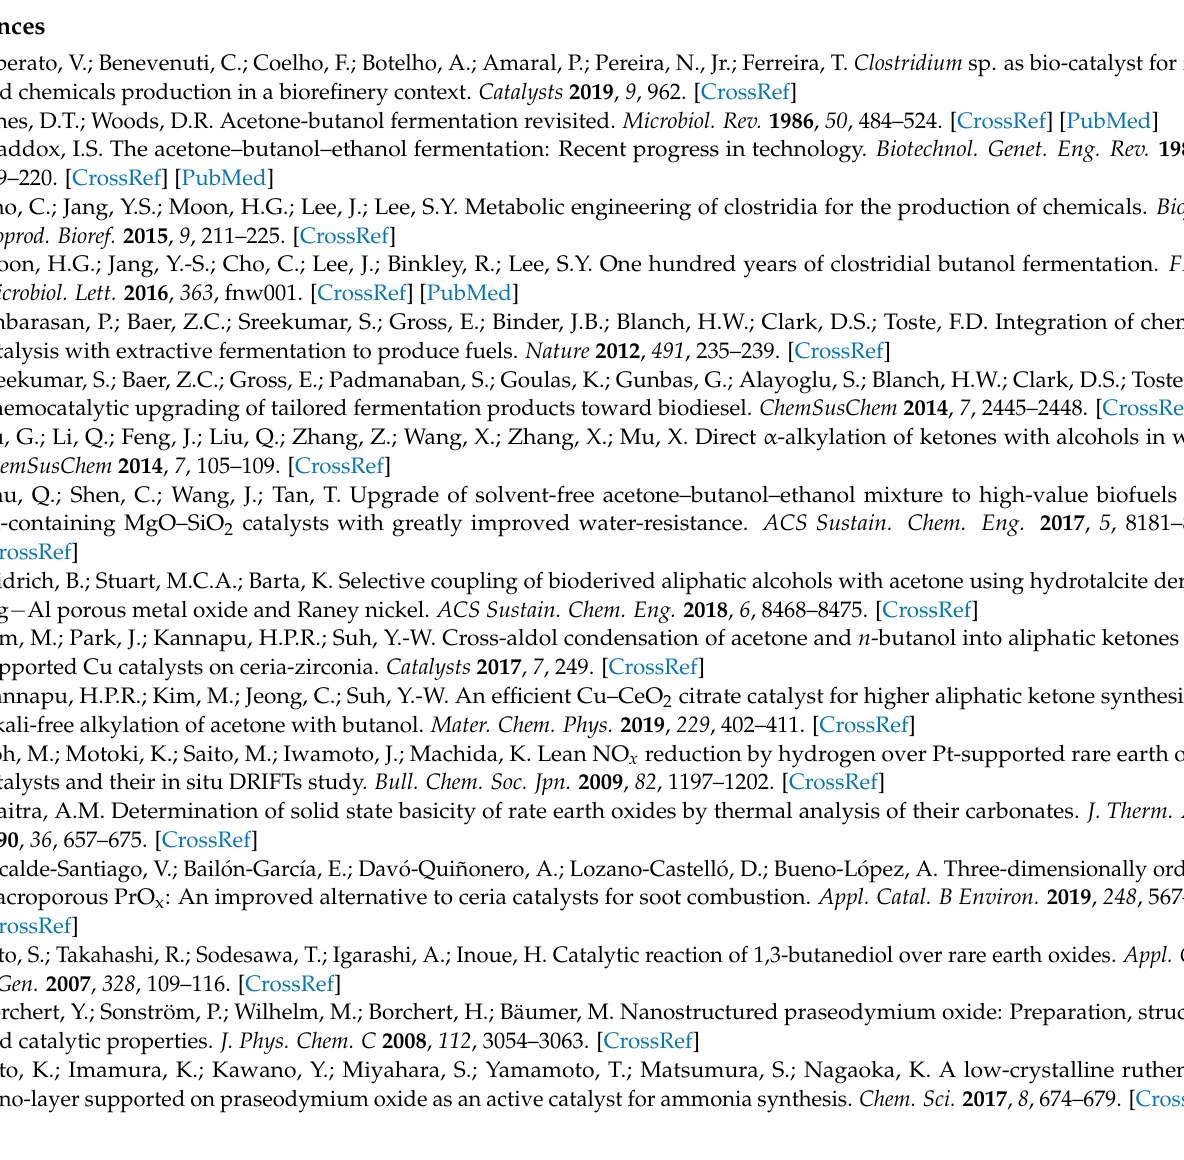
the square symbol. Figure S3: TEM images, Cu EDS mapping images, and line scanning results (obtained by tracking the orange line in the first image): (a) 1Cu/Pr 2 Zr 2 O 7 , (b) 3Cu/Pr 2 Zr 2 O 7 , and (c) 5Cu/Pr 2 Zr 2 O 7